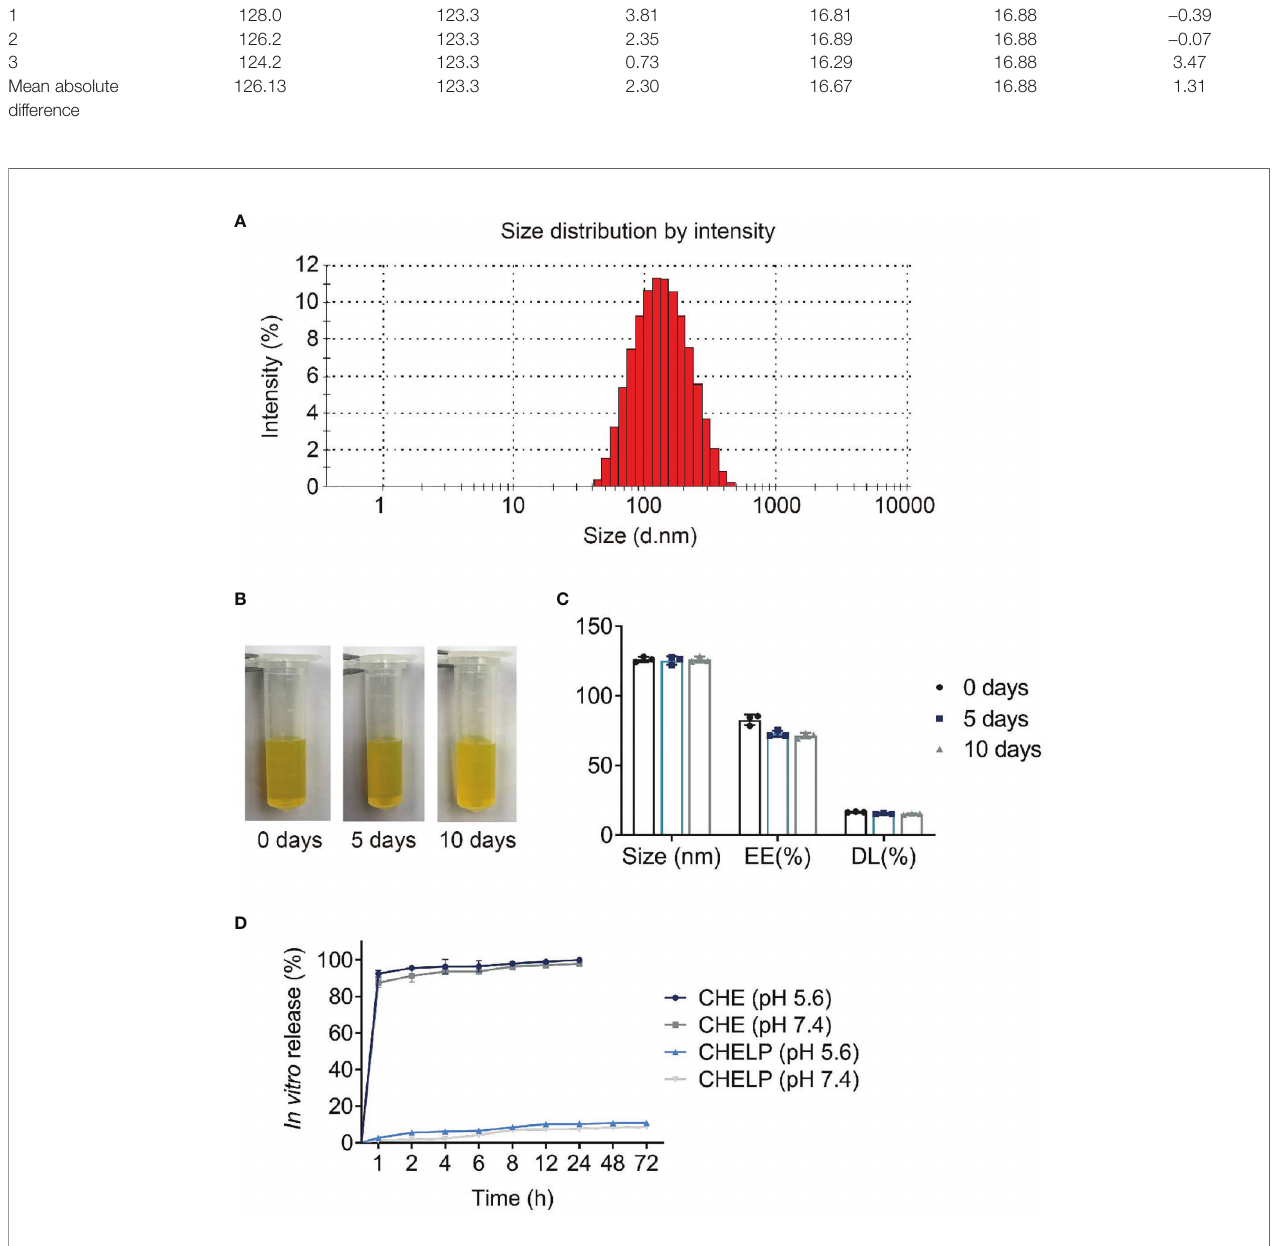
FIGURE 7 | Characterization of CHELP. (A) The size distribution of CHELP; (B, C) The stability of CHELP; (D) In vitro release of